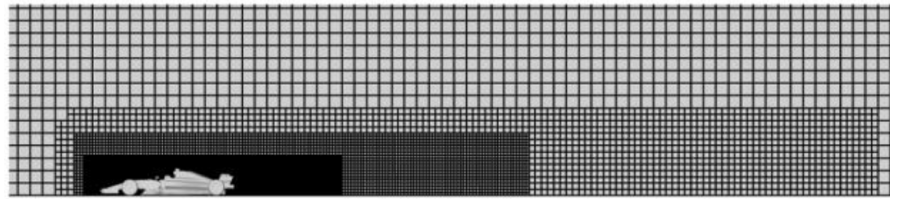
Figure 4. Overall mesh and refinement enclosures of the free stream case.